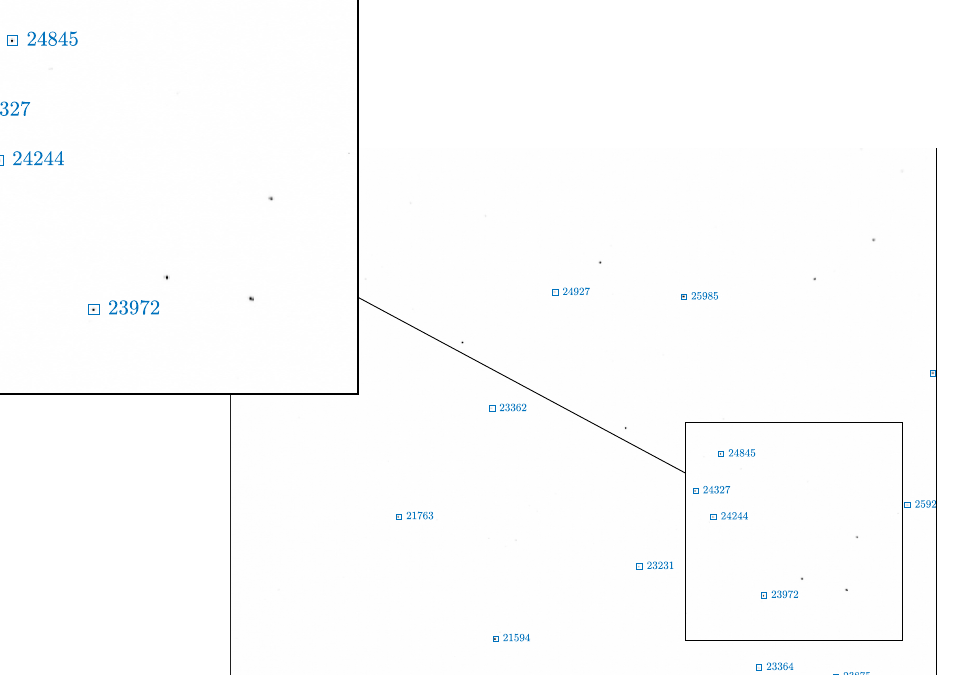
Figure 18. An example image, in reversed colors, of detected stars in a deep-space image for attitude determination. The identified stars are shown in blue boxes with the corresponding identifiers. The image is framed to show the image borders. Details of the image are shown in the